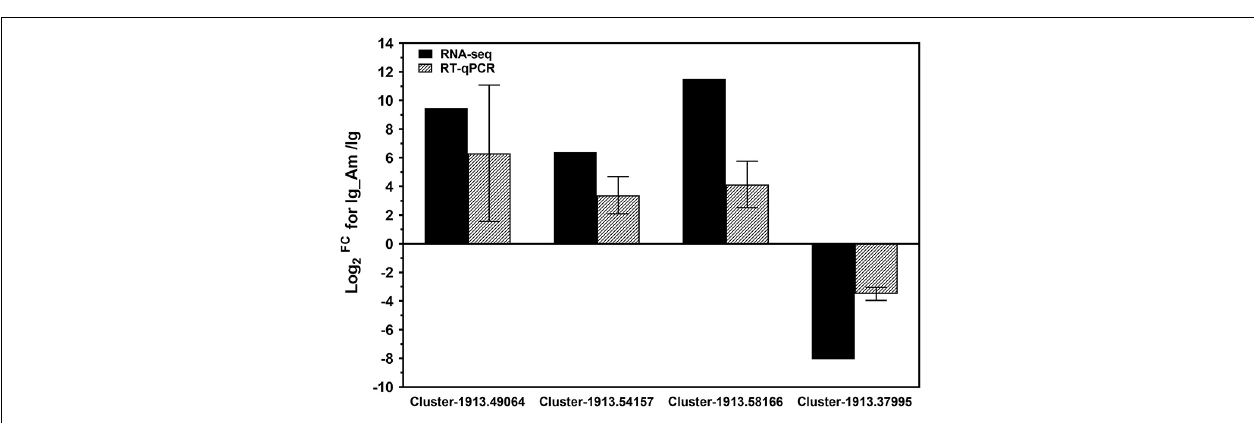
FIGURE 4 | Experimental confirmation of RNA-seq data on relative fold change level of the selected differentially-expressed genes (DEGs) by real-time quantitative PCR (RT-qPCR) analyses. The results from RNA-Seq and RT-qPCR, are shown by bars with different patterns. The selected DEGs included calcium-dependent protein (Cluster-1913.49064), photosystem II protein D1 (Cluster-1913.54157), aspartate aminotransferase (Cluster-1913.58166) and biotin synthase (Cluster-1913.37995) for I. galbana . RT-qPCR data represent the mean ± standard error (SE) of three independent